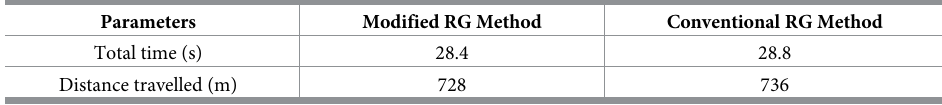
Table 4. Comparison of time and distance in scenario